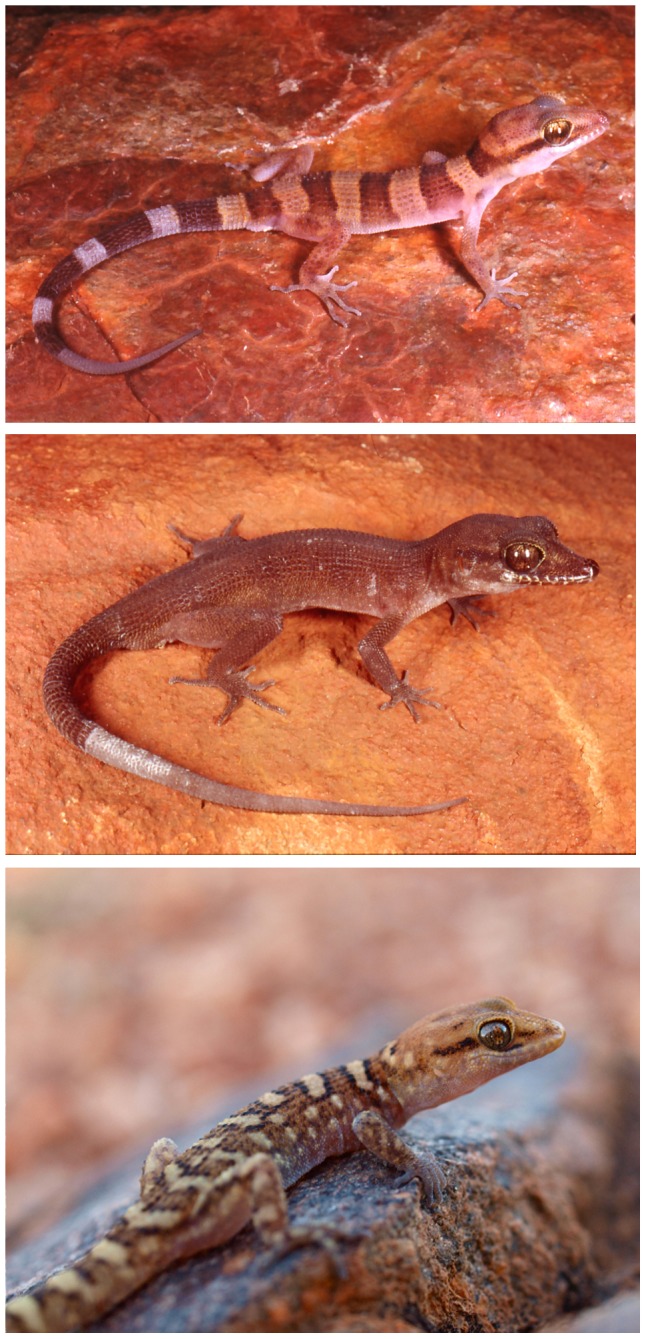
Photographs in life.(A) Heteronotia spelea in life: Paraburdoo, WA (image: B. Maryan); (B) Heteronotia atra
sp. nov. in life: 5 km south of Lake Poongkaliyarra, WA (image: B. Maryan); (C) Heteronotia fasciolatus
sp. nov. in life: Harts Range, central Australia, NT (image: M. Pepper).